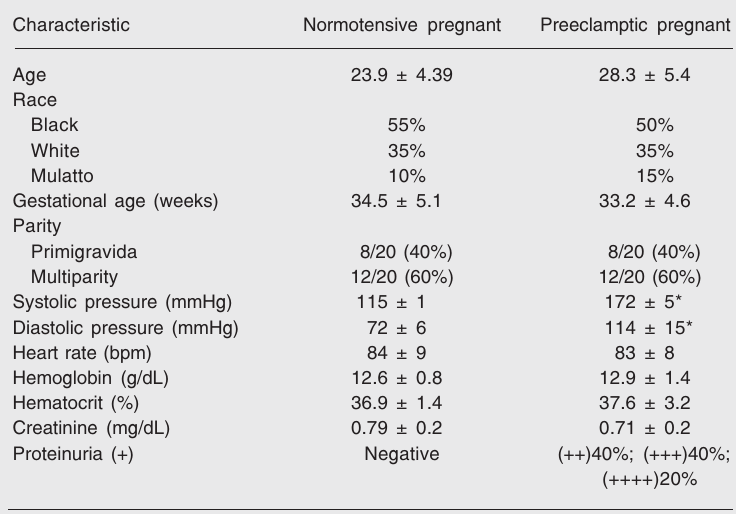
Table 1. Demographic and laboratory data of pregnant normotensive and preeclamptic